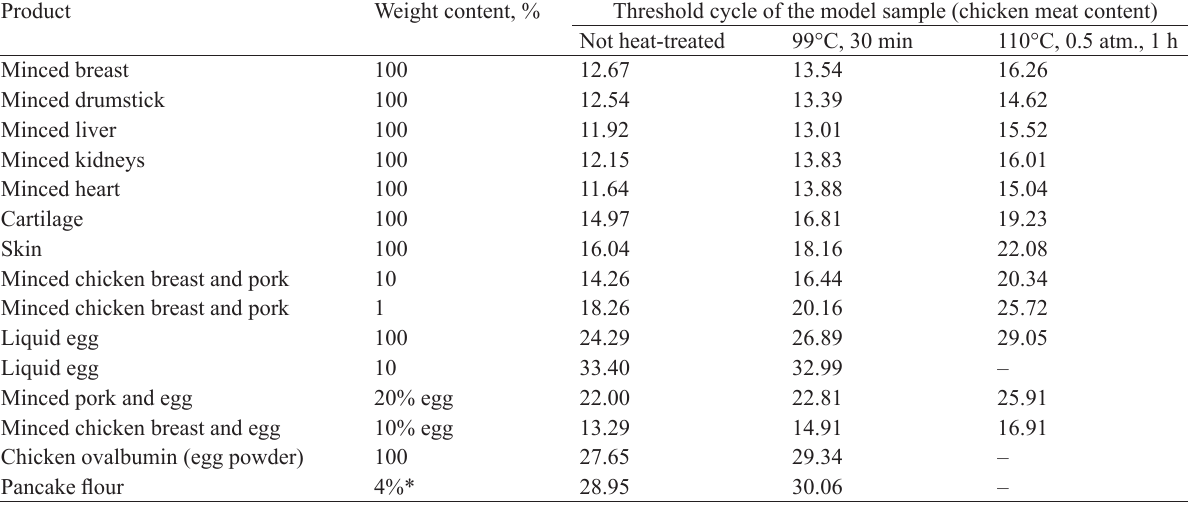
Table 1 PCR results for model samples Product Weight content, %